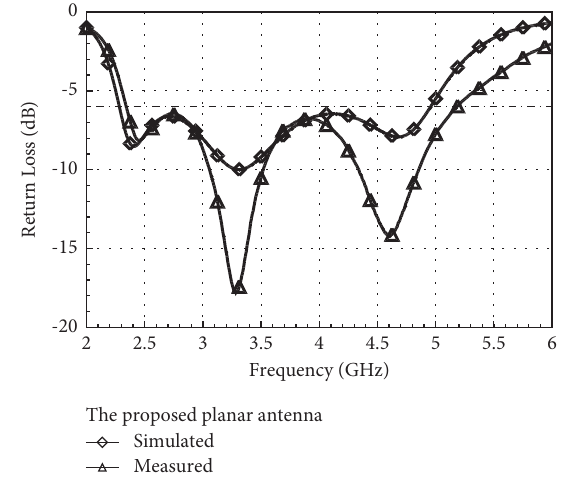
Figure 3: Simulation and measurement reflection coefficients for the suggested planar